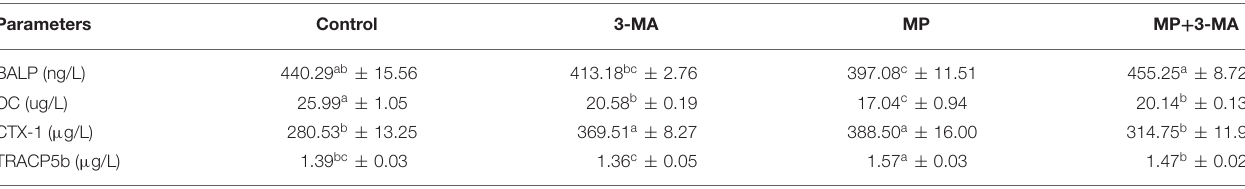
TABLE 7 | Levels of plasma bone metabolism parameters. Parameters